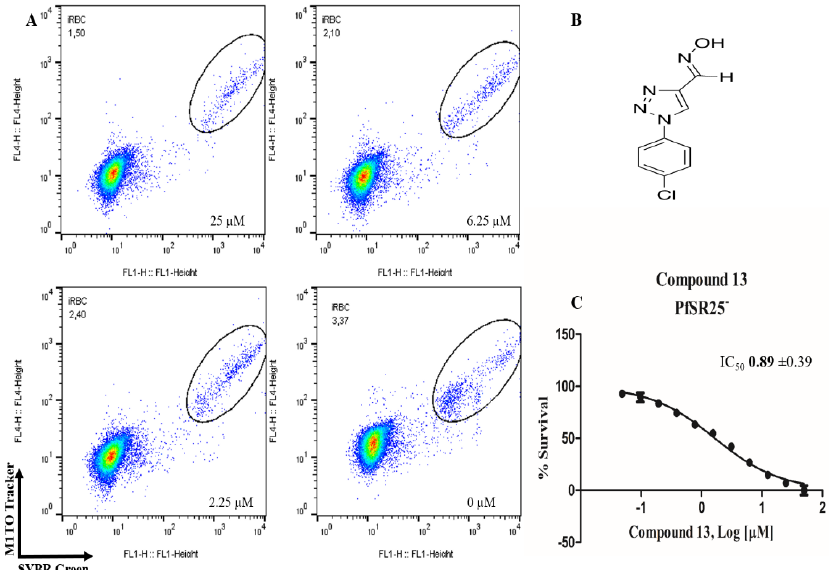
Figure 5. Determination of the antimalarial activity of the compound 13. ( A ) Dot plots is shown for four different concentrations (25, 6.25, 2.25 µM and control) at the end of 72 h of incubation. ( B ) Chemical structure of the compound 13 . ( C ) Survival curve of the growth of P. falciparum PfSR25- in the presence of the compound 13 at different concentrations (0.0488–50 µM).